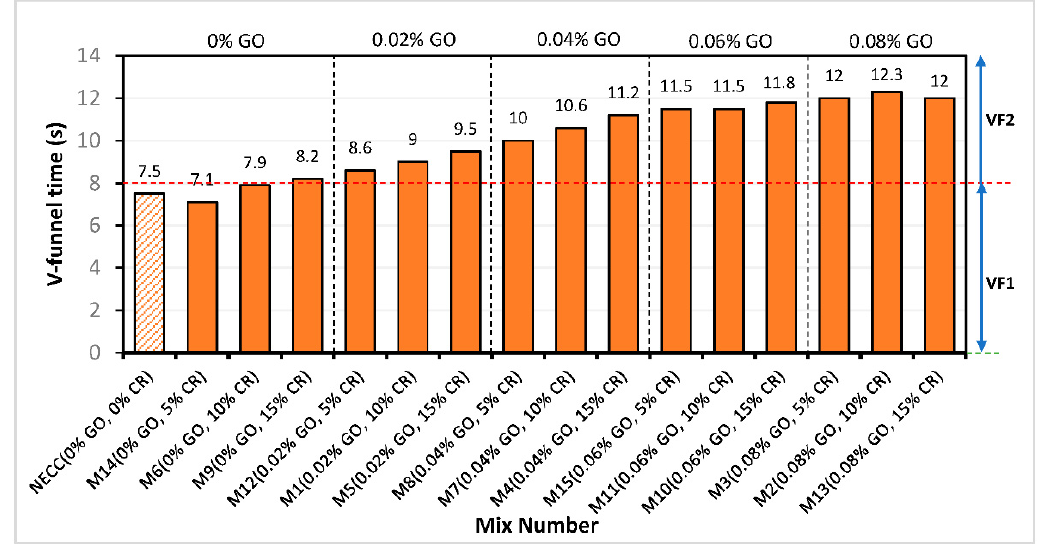
Figure 6. V-funnel time.